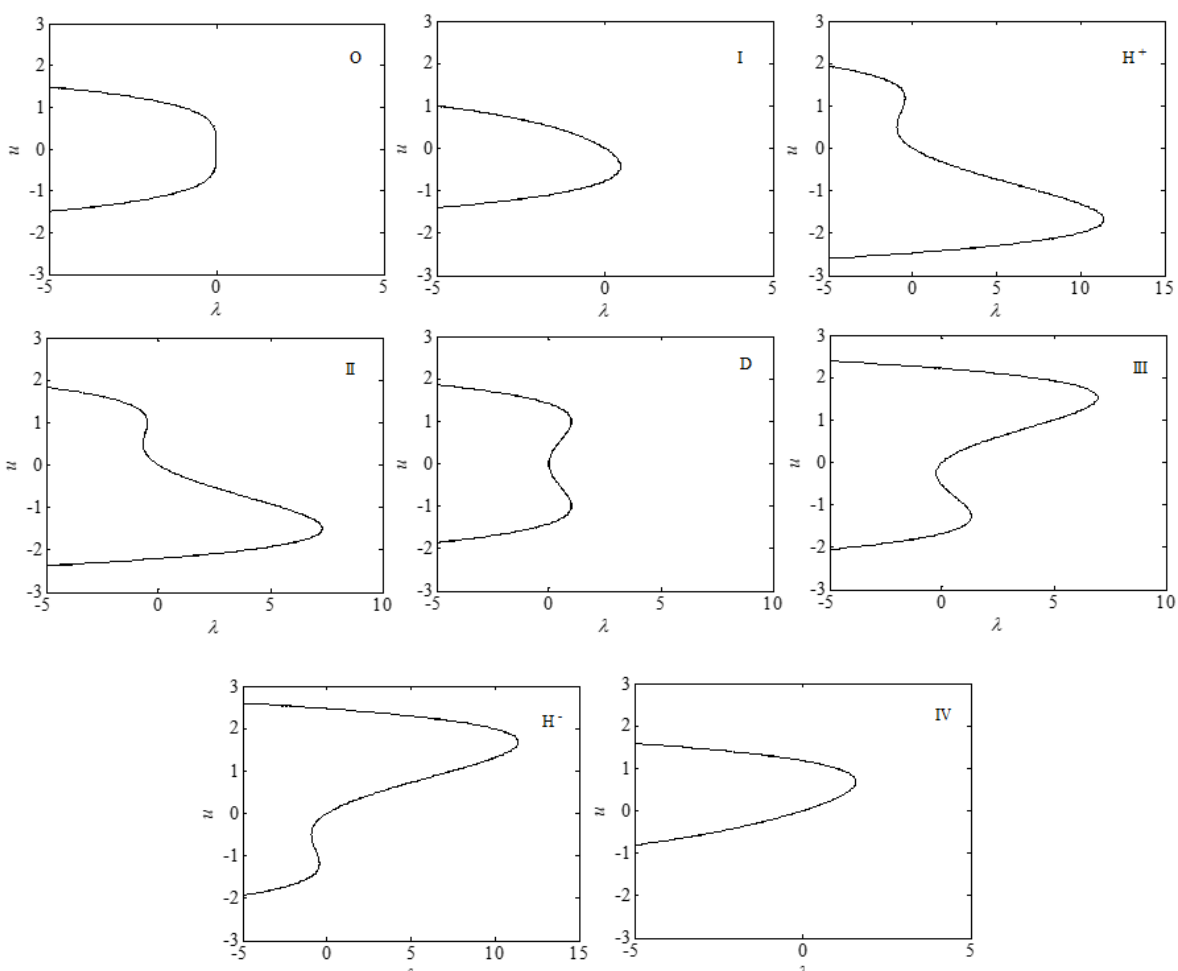
Figure 20. Transition set of nonlinear coupled vibration system of hot rolling mill rolls with d 3 = 0.